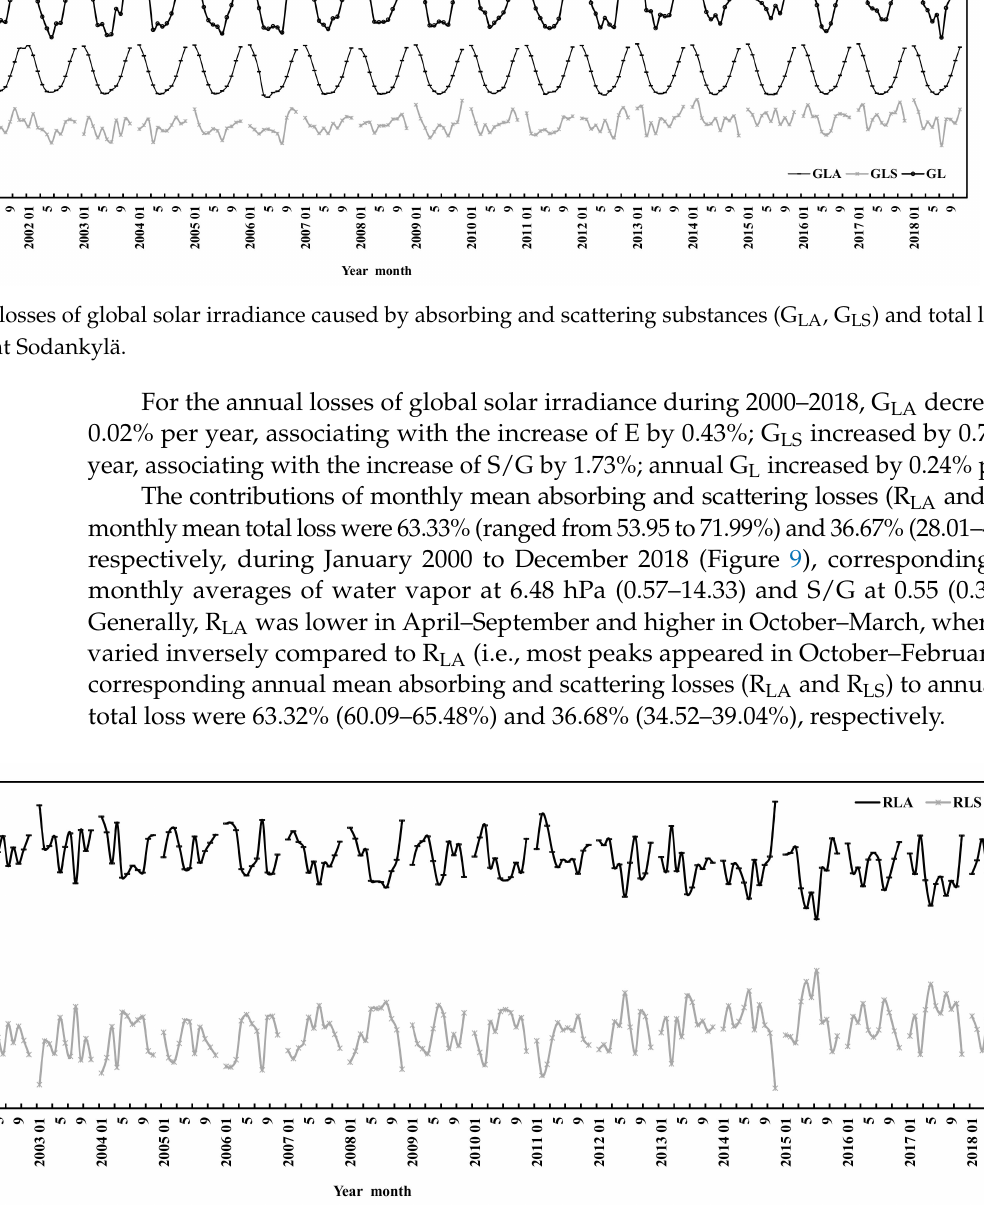
Figure 9. Contributions (R LA , R LS ) of monthly absorbing and scattering losses to monthly total loss at